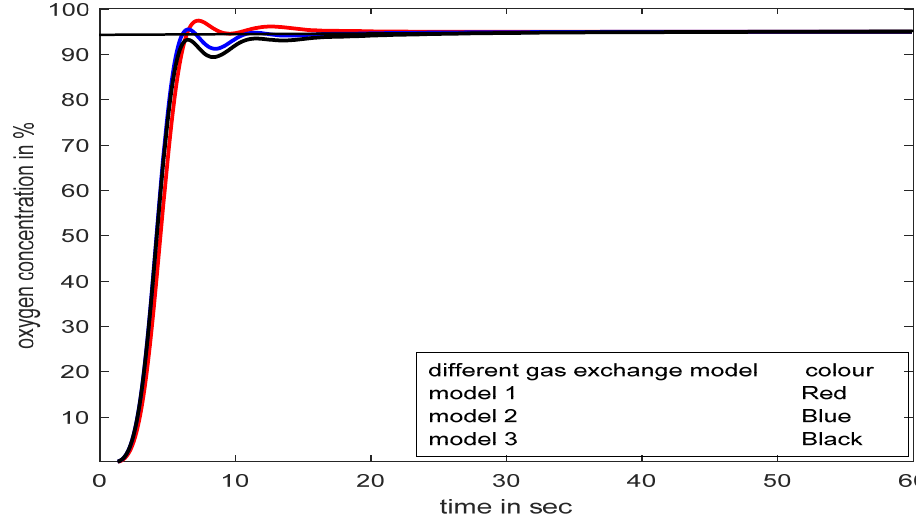
Figure 18 . Process responses with SFPIMRAC for model parameters variations. Figure 18. Process responses with SFPIMRAC for model parameters variations.